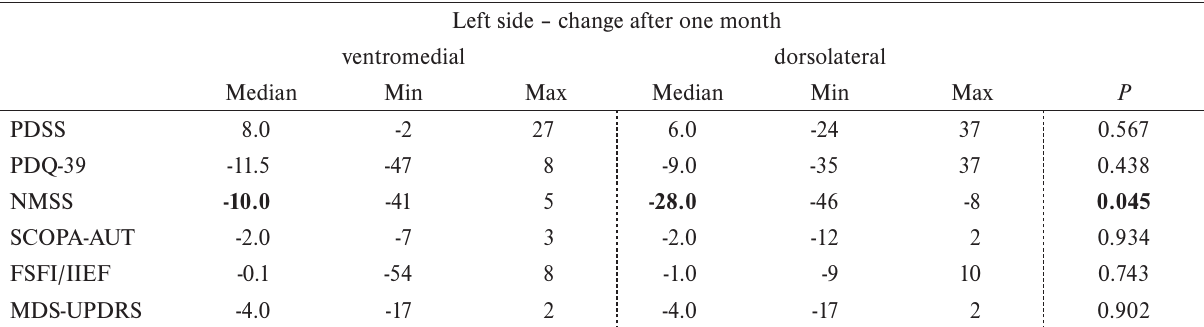
Table 1. Change in clinical scales after 1 month – left side, division into two parts. Left side – change after one month